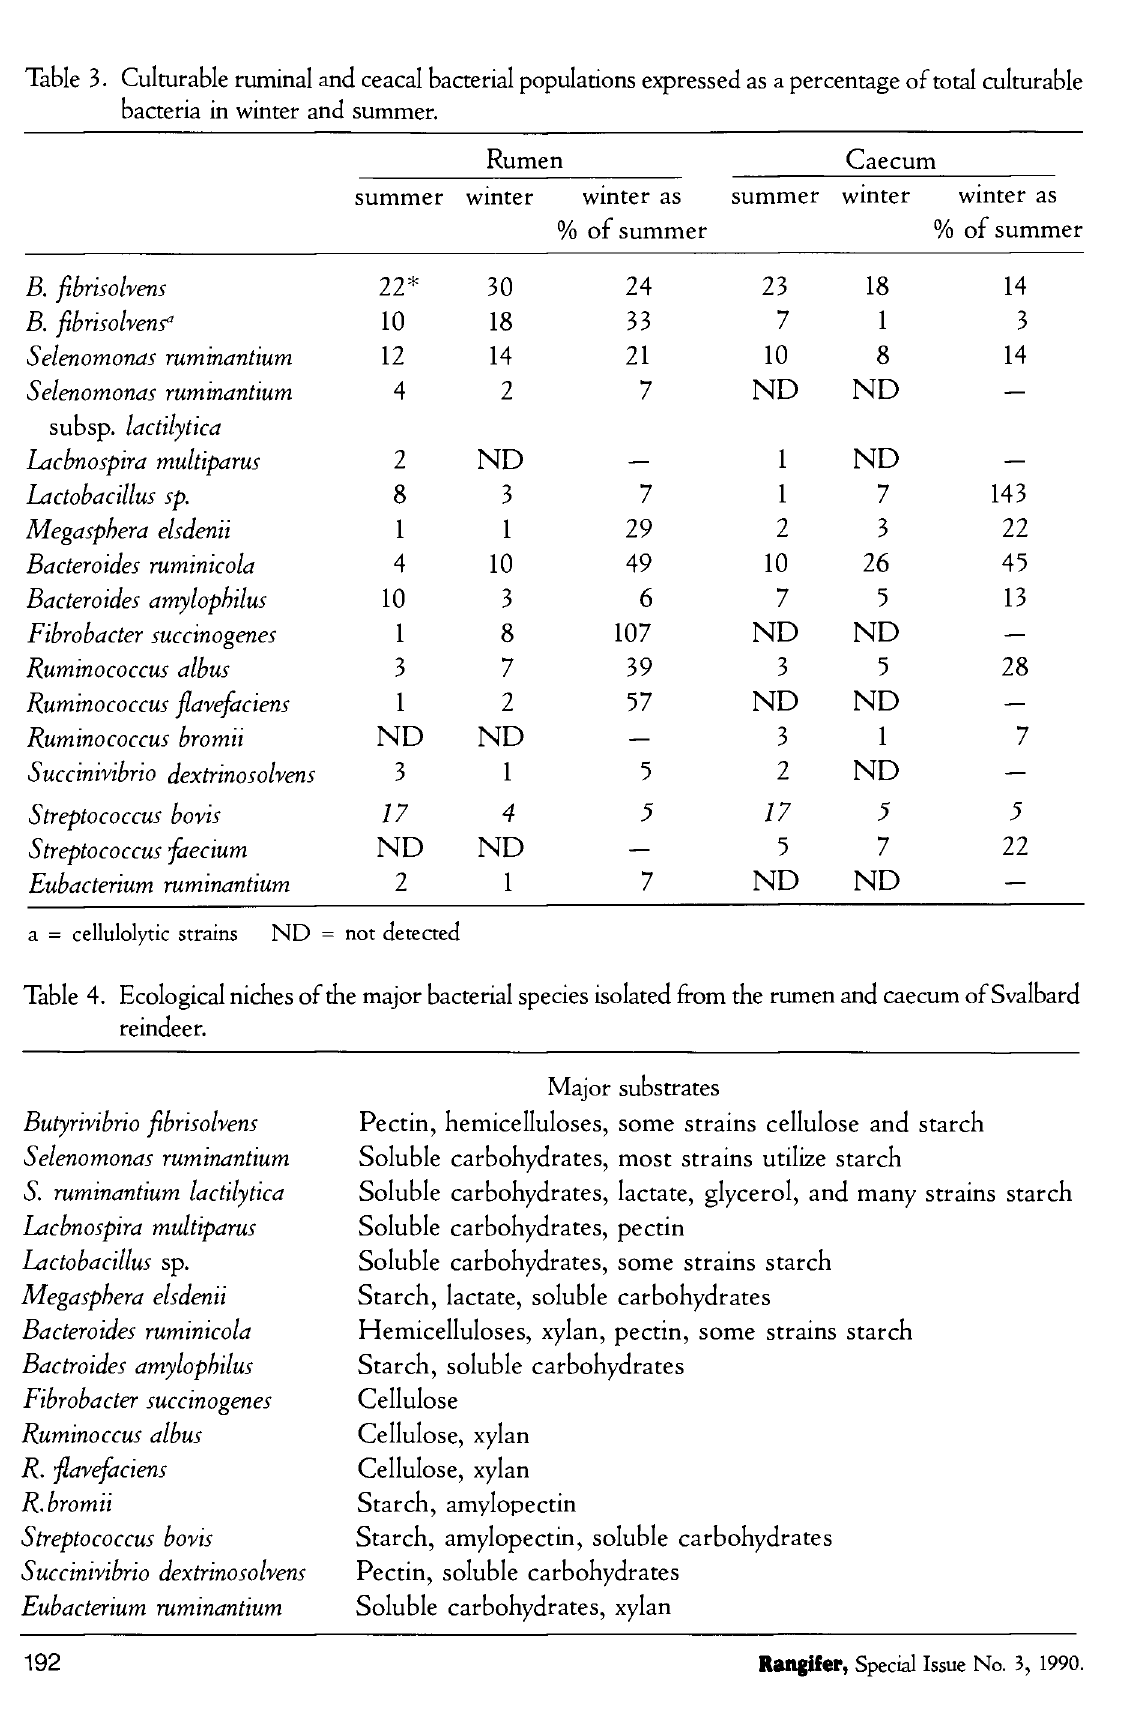
Table 4. Ecological niches of the major bacterial species isolated from the rumen and caecum of Svalbard